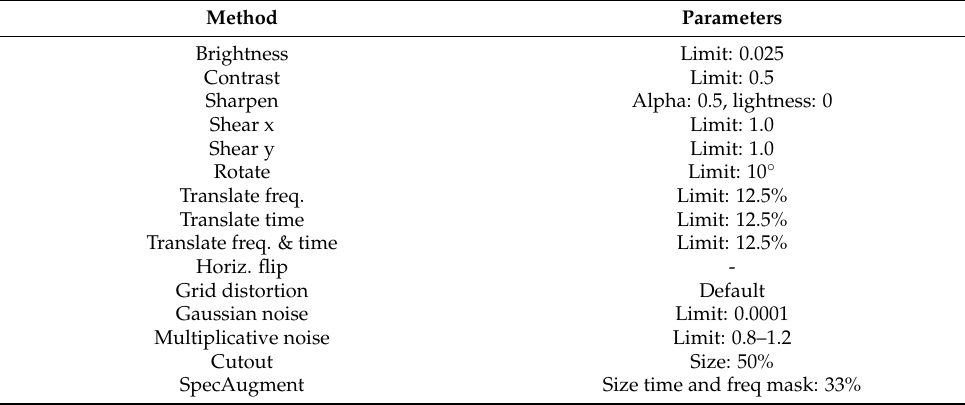
Table A4. Augmentation methods with corresponding parameter